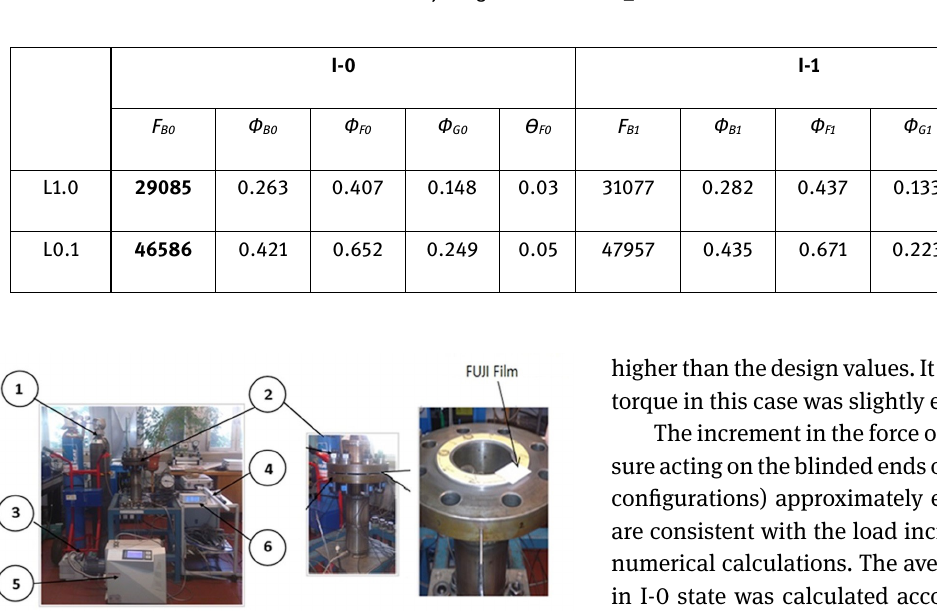
Table 5: The results of numerical calculation of the joint gasketed with FG_2 material